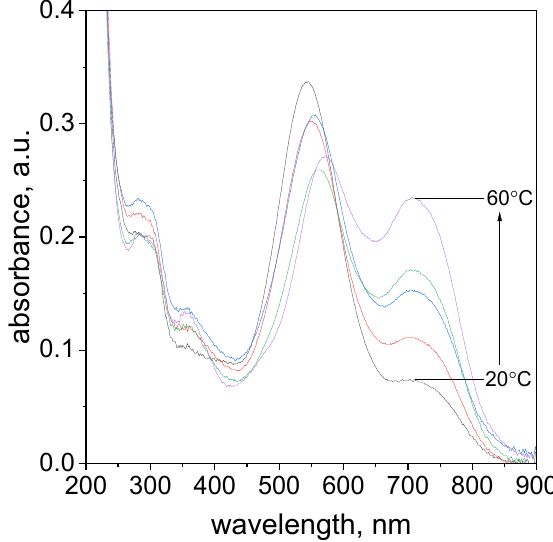
Figure 6. The UV–Vis spectra evolution of the solution containing the mixture of tropaeolin OO and Pd(II) at different temperatures 20–60 ◦ C, absorbance change for all temperatures after 17.5 h. Conditions: volumetric ratio: 2.5 mL Pd(II):1.5 mL TR the value of concentration of Pd(II) ions after mixing with tropaeolin OO:C 0,MO = 1.875 × 10 − 5 mol/dm 3 , C 0,Pd(II) = 3.125 × 10 − 5 mol/dm 3 , pH =